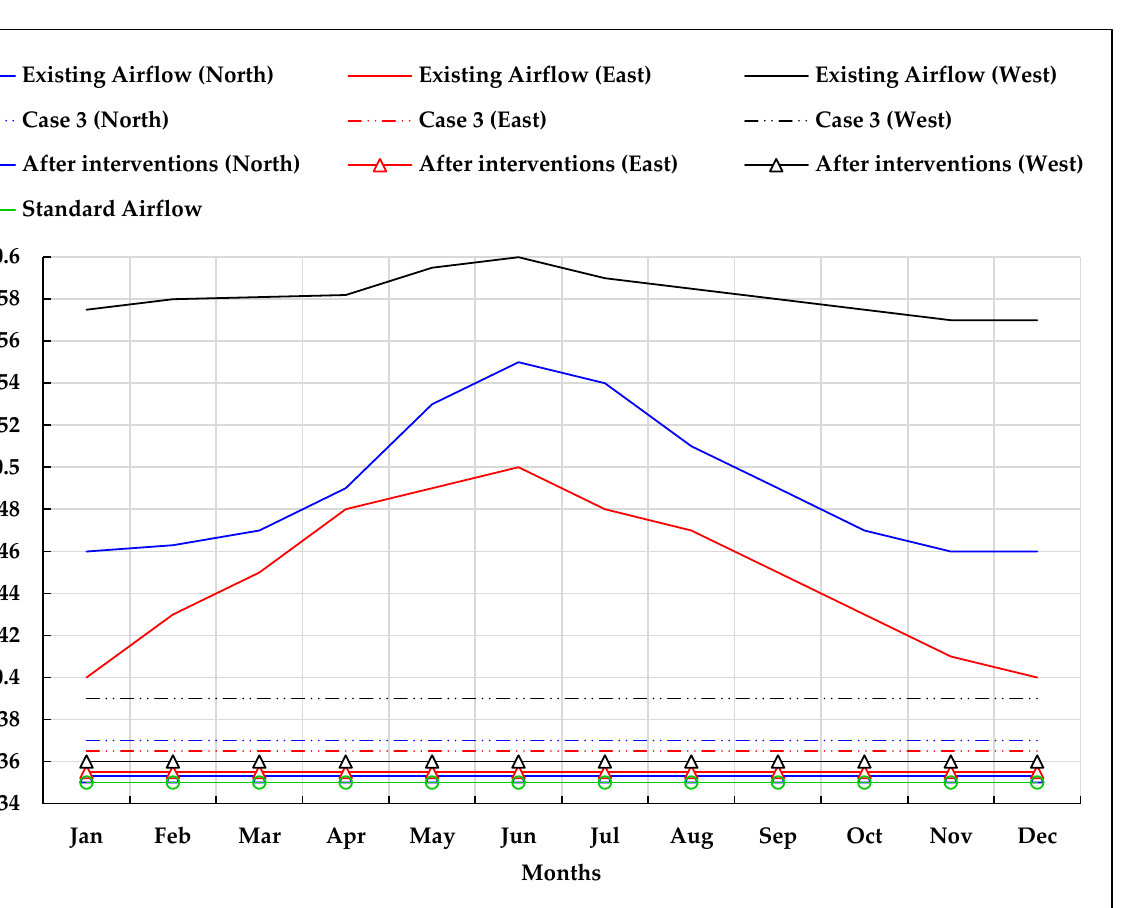
Figure 8. Airflow in the existing ACB; airflow in the existing ACB with EAHEs representing the north, east, and west wings (case 3); and airflow in the renovated building envelope with EAHEs representing the north, east, and west wings.